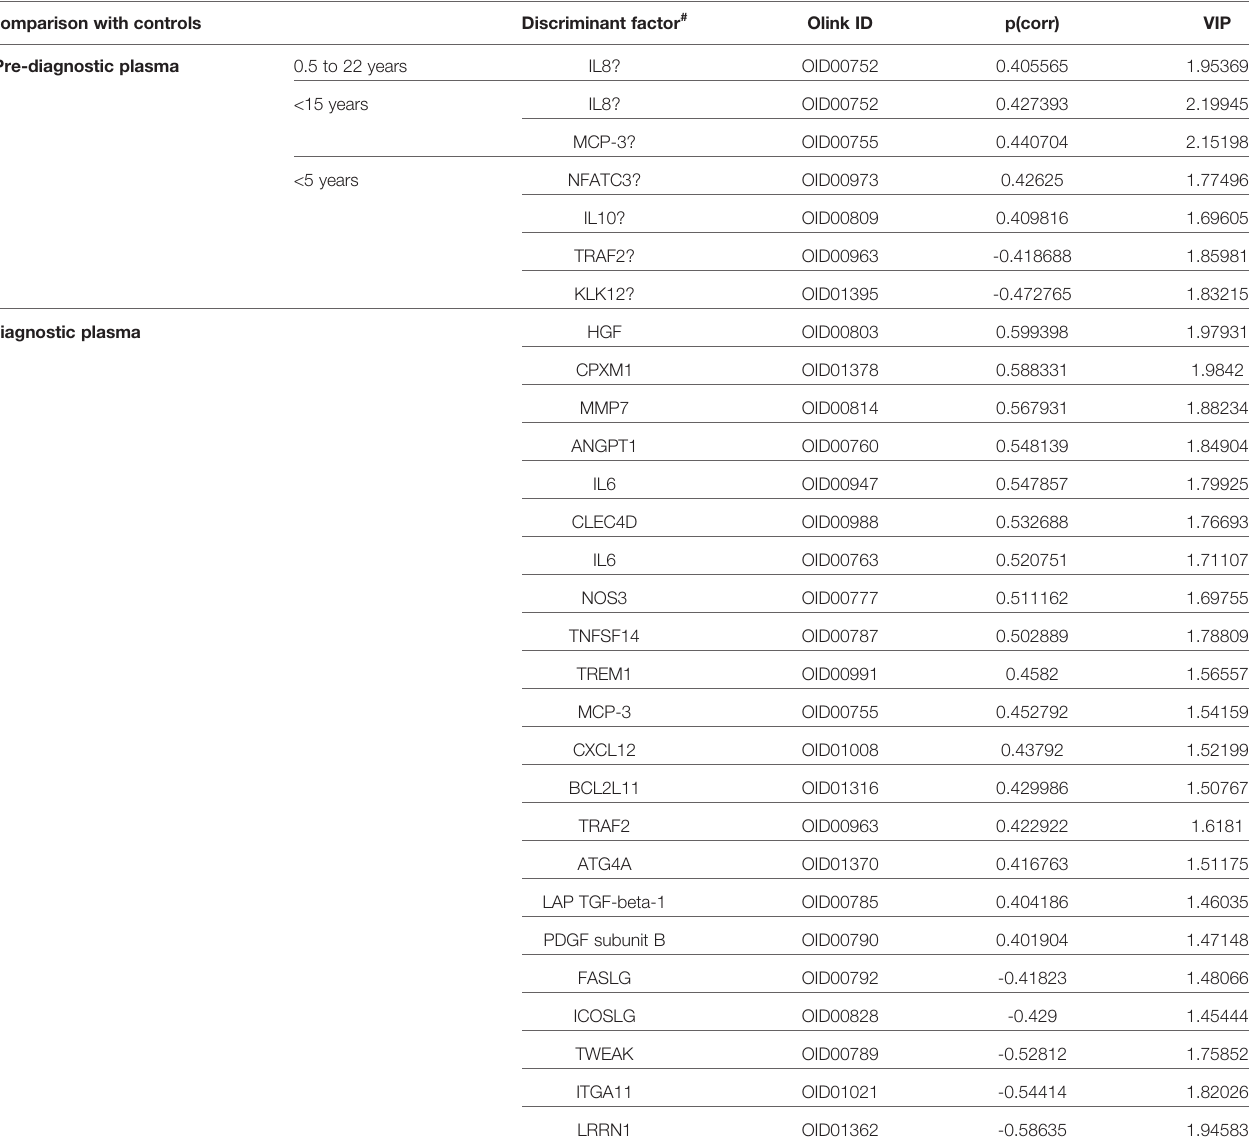
TABLE 2 | List of discriminant factors identi fi ed from comparisons between different groups of samples. Comparison with